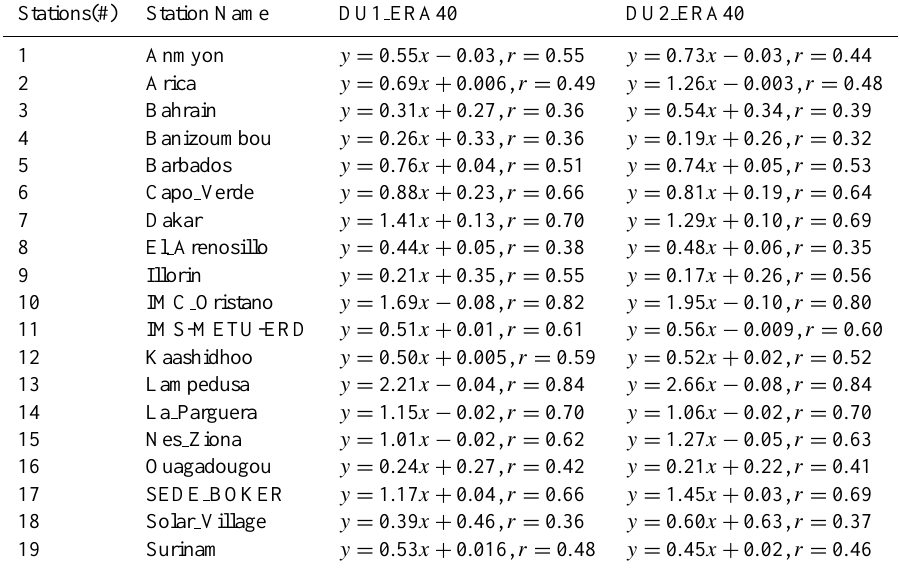
Fig. 10. Comparison of modelled and measured monthly dust deposition fluxes (gm − 2 month − 1 ) at 3 locations in Florida (FAMS Net- work; measurements are provided as a 3-yr means for 1994–1996): Lake Barco (LB) (82.02 ◦ W, 29.67 ◦ N), Tamiami Trail (TT) (80.82 ◦ W, 25.77 ◦ N) and Little Crawl Key (LCK) (80.98 ◦ W, 24.75 ◦ N). The left panels show the total deposition fluxes and the right panels the wet deposition fluxes (gm − 2 month − 1 ). Table 10. Statistics of the 19 AERONET stations (daily average AOD). The station numbers correspond to the locations shown in Fig.